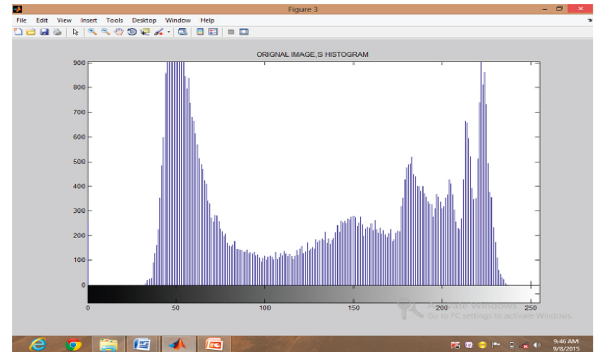
Figure 13: Histogram of original image of baboon.